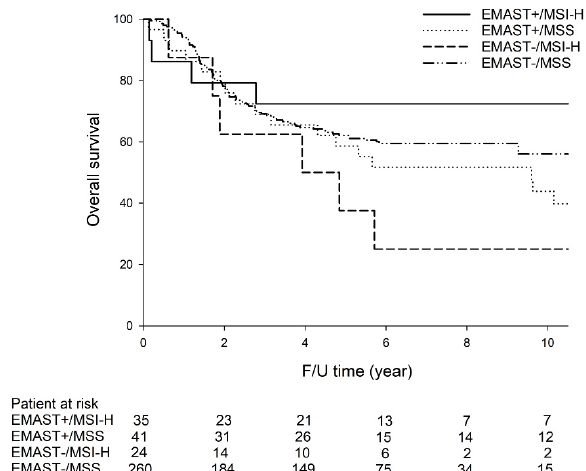
Figure 1. The five-year OS rates (72.4% vs. 37.5%, p = 0.046) were significantly higher in GC patients with EMAST+/MSI-H than in GC patients with EMAST − /MSI-H. There was no significant difference in five-year OS rates between other GC subtypes.